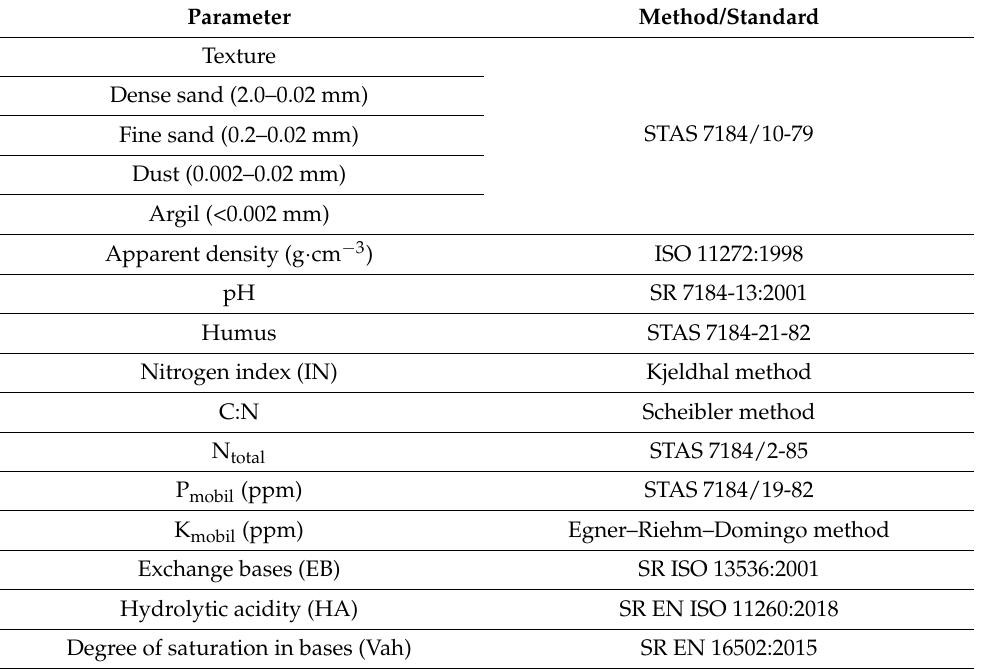
Table 2. Methods of analysis of characteristics of agricultural soils